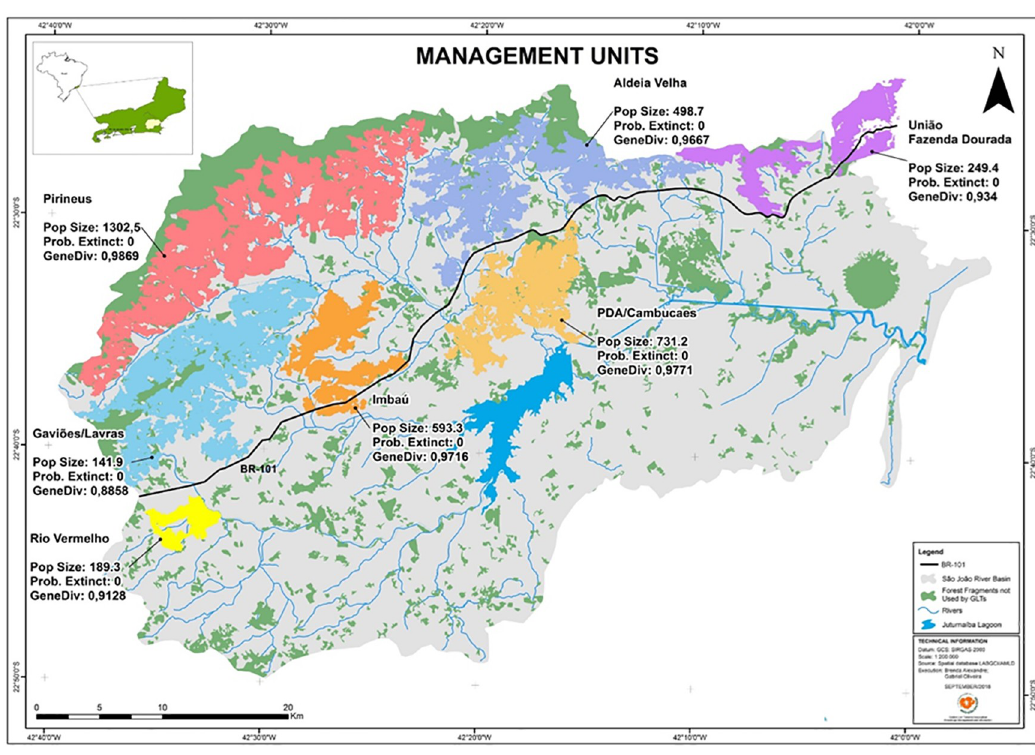
Fig 1. Map of current geographic distribution of golden lion tamarins. Map showing the current geographic distribution of golden lion tamarins. Colored polygons represent blocks of connected forest fragments (as we understood connectivity in 2014) which we refer to as management units with GLT populations. Dark blue is a body of water, green shows forest fragments not used by GLTs. Estimates of GLT population sizes and forest area are shown for each management